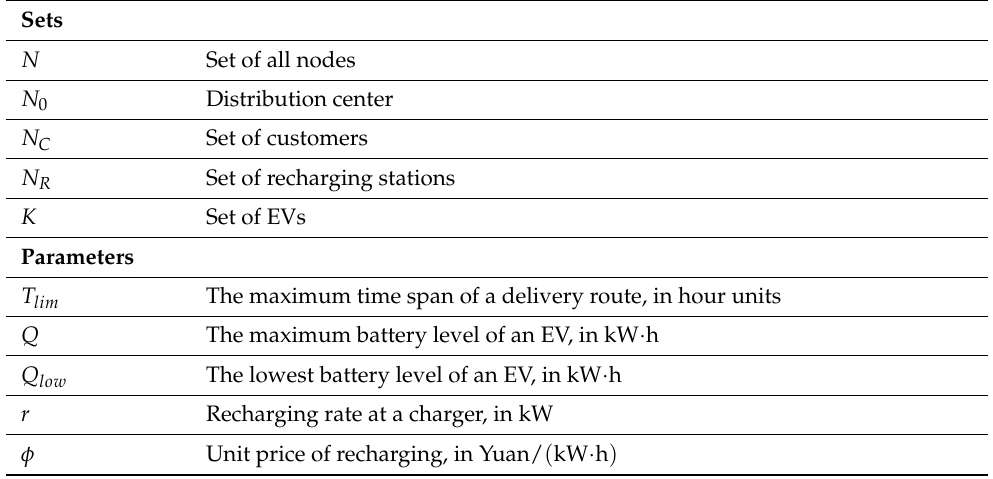
Table 2. Notation of variables and parameters in the EVRPTW-DC